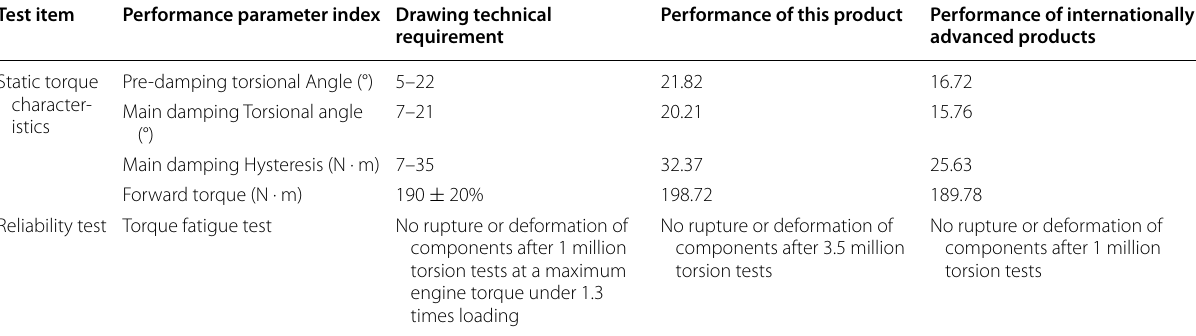
Table 1 Comparison of main parameters of current, foreign, similar technologies Test